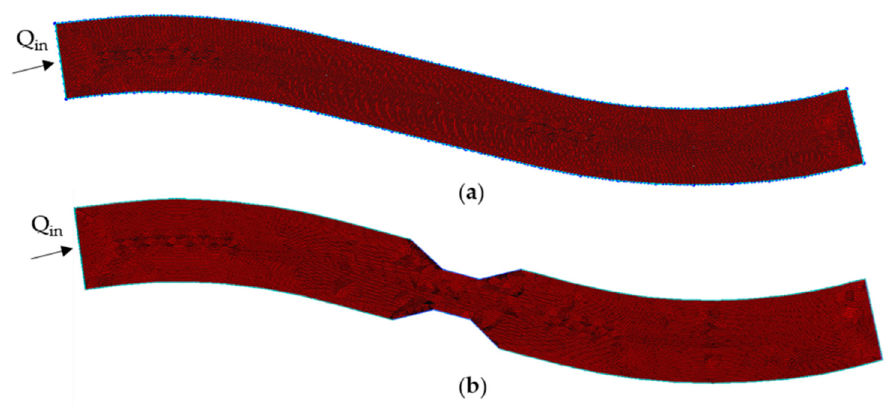
Figure 4. ( a ) Numerical discretization of the S-shaped flume. ( b ) Numerical domain of the S-shaped flume with narrowing.